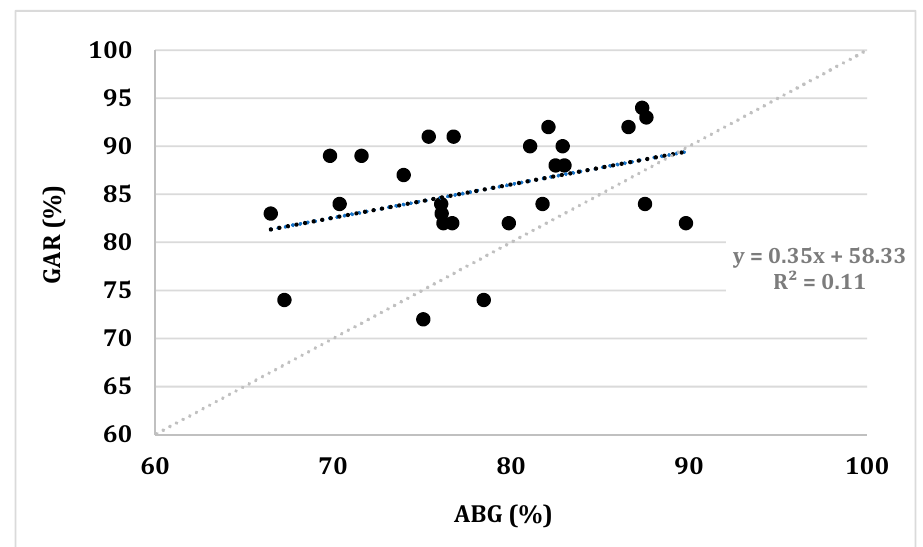
≤ 70%), GAR did not report any SpO 2 readings.